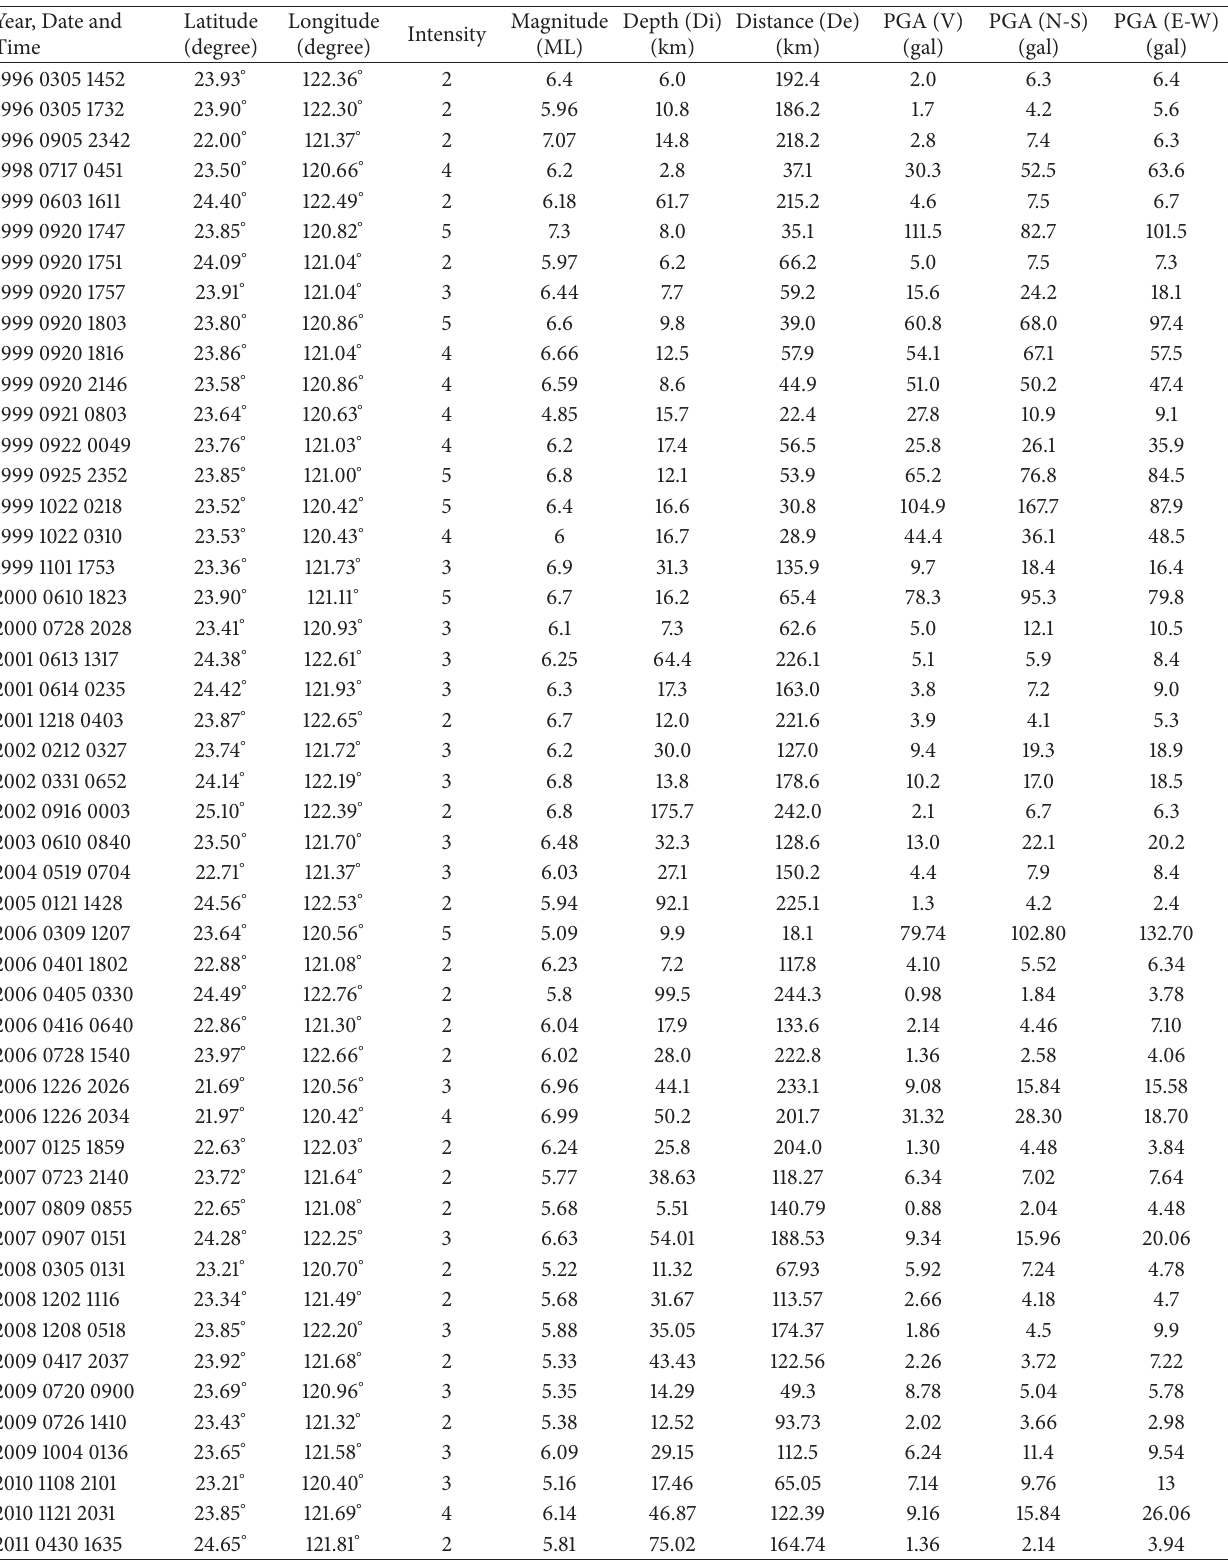
Table 1: Typical seismic data sets at subdivision zone A7 (checking station